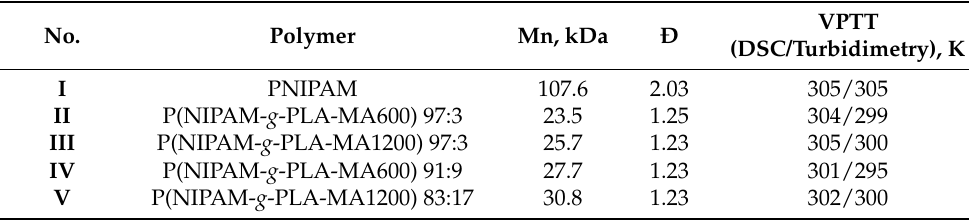
Figure 1. Structures of radical (2,2,6,6-tetramethylpiperidin-1-yl)oxyl (TEMPO) ( a ) and graft co- polymers P(NIPAM- g- PLA) ( b ). Table 1. Characteristics of the polymers and the abbreviation used [5,26]. Mn is the number average molecular weight, Ð is polydispersity.